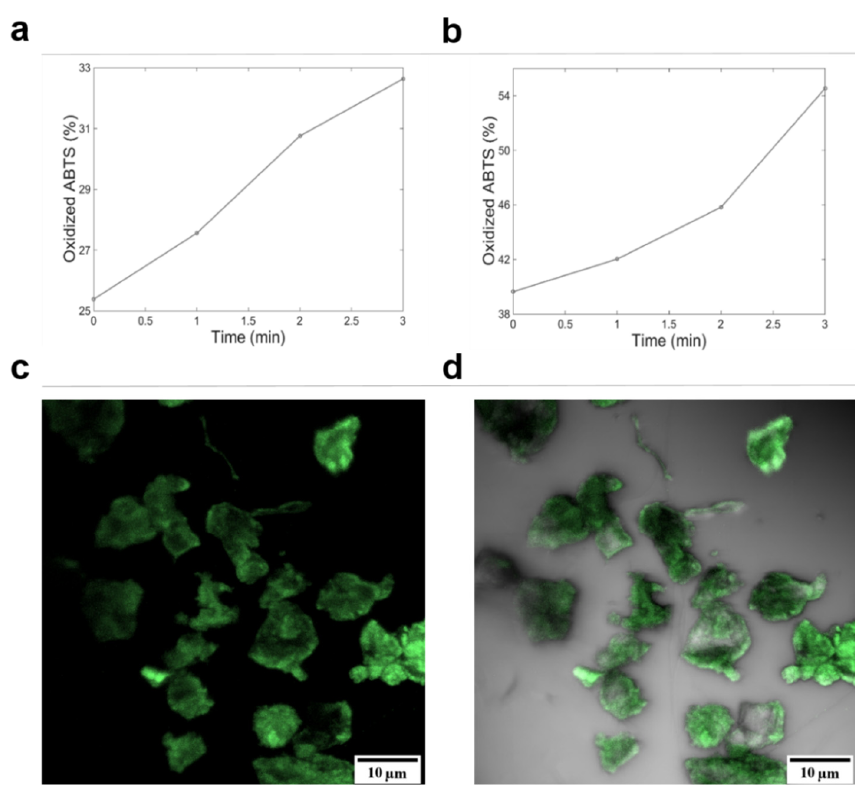
Figure 4. Light transmission imaging of 2,2 ′‐ azino ‐ bis(3 ‐ ethylbenzothiazoline ‐ 6 ‐ sulfonic acid) diammonium salt (ABTS) catalyzed at pH 4.0 inside the microcapsules. ( a ) AC ‐ C and ( b ) PSS ‐ C, ( c ) confocal microscopy images of AC ‐ C at magnification 40x of ABTS + Hoechst 33342 fluorescence with Alexa fluor ® 405 observation parameters, and ( d ) transmission image merged with ( c ) channel. Fluorescence demonstrated the ability of ABTS to penetrate the move freely across the microcapsules’ porous walls.